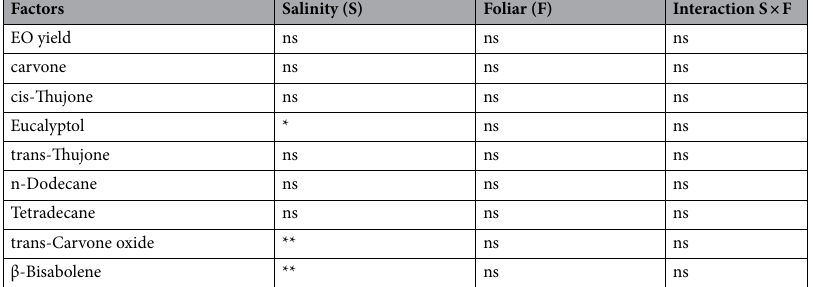
Table 8. Effect of salinity levels (0, 50, 100 and, 150 mM NaCl) and foliar applications (no-foliar, 2 g L −1 glucose, 2 g L −1 KNO 3 , and 2% Dobogen) on the essential oil yield (mL/m 2 ) and components (with >